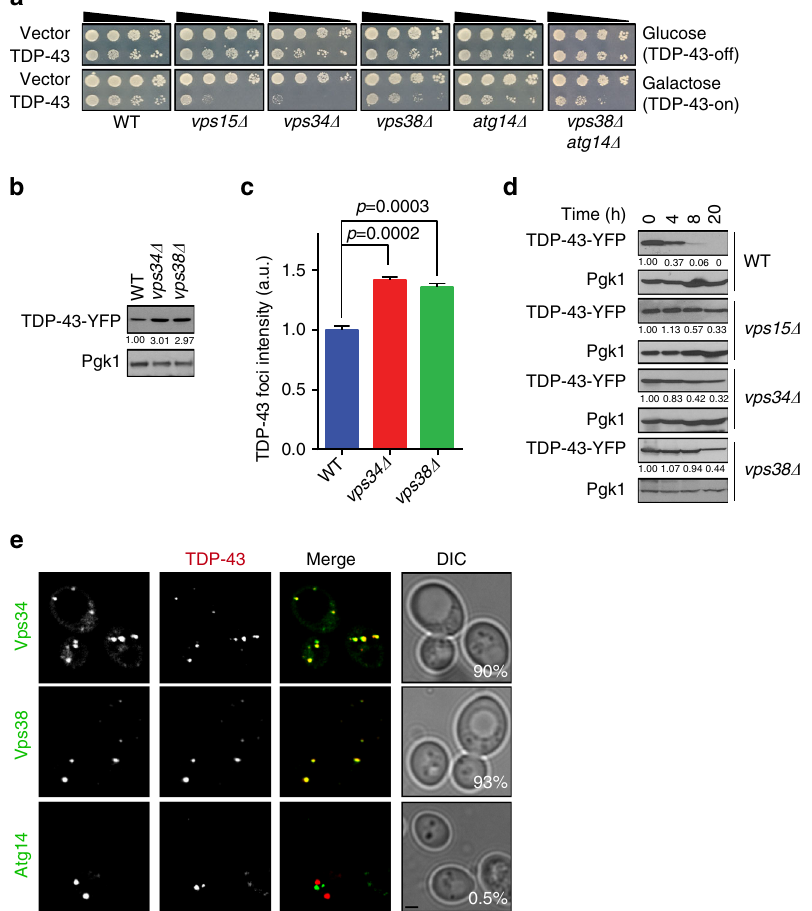
Fig. 2 Yeast PI3K complex II affects TDP-43 toxicity and turnover. a Serial dilution growth assay of indicated isogenic null strains expressing vector and TDP-43. b , c Indicated strains expressing TDP-43-YFP were examined/quanti fi ed for overall TDP-43-YFP levels as in Fig. 1e ( b ) or foci intensity ( c ). Signi fi cance was assessed by one-way ANOVA. Repeated data are shown as mean ± s.e.m. d TDP-43-YFP turnover in indicated strains, as in Fig. 1a. e WT strain co-transformed with TDP-43-mRuby2 and Vps34-GFP, Vps38-GFP, or Atg14-GFP. % value indicates co-localization of TDP-43 foci with Vps34, Vps38, or Atg14. Scale bar = 2 µ